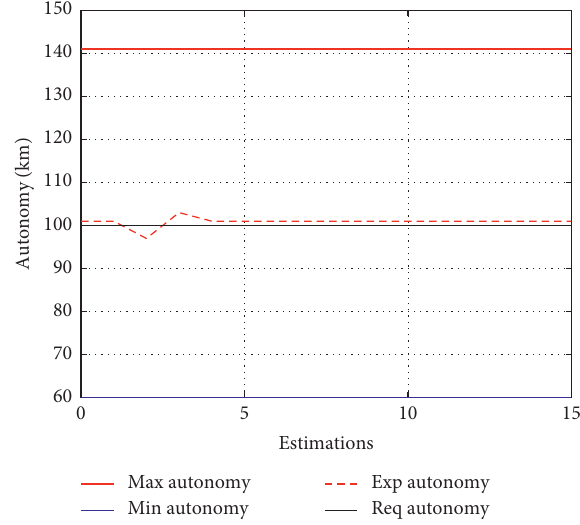
Figure 14: Autonomy